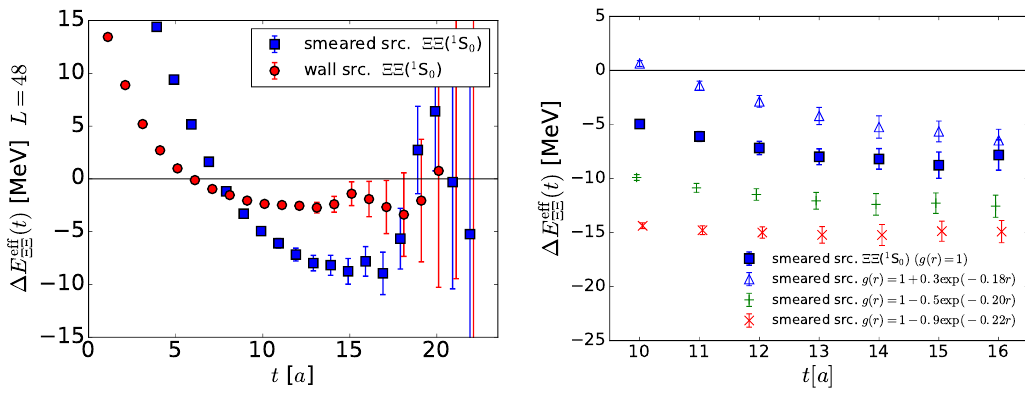
Figure 1 . (Left) The source operator dependence of the e(cid:11)ective energy shift (cid:1) E e(cid:11) ( t ) for (cid:4)(cid:4) ( 1 S 0 ) using the wall source (red circles) and the smeared source (blue squares) for L = 48 [1]. (Right) The sink operator dependence of the same quantity with the smeared source